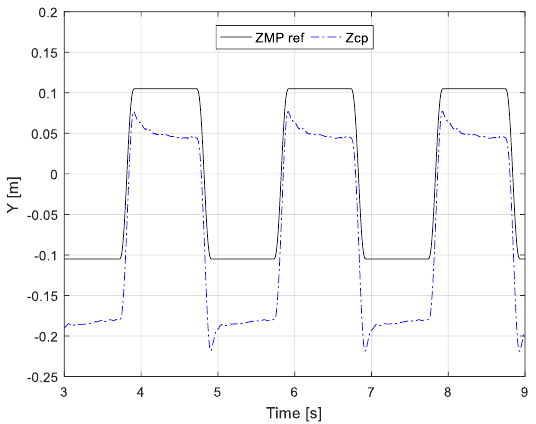
Figure 9. Reference and measured ZMPs with/without capture-point feedback on tilted ground. The reference corresponds to the original walking pattern.